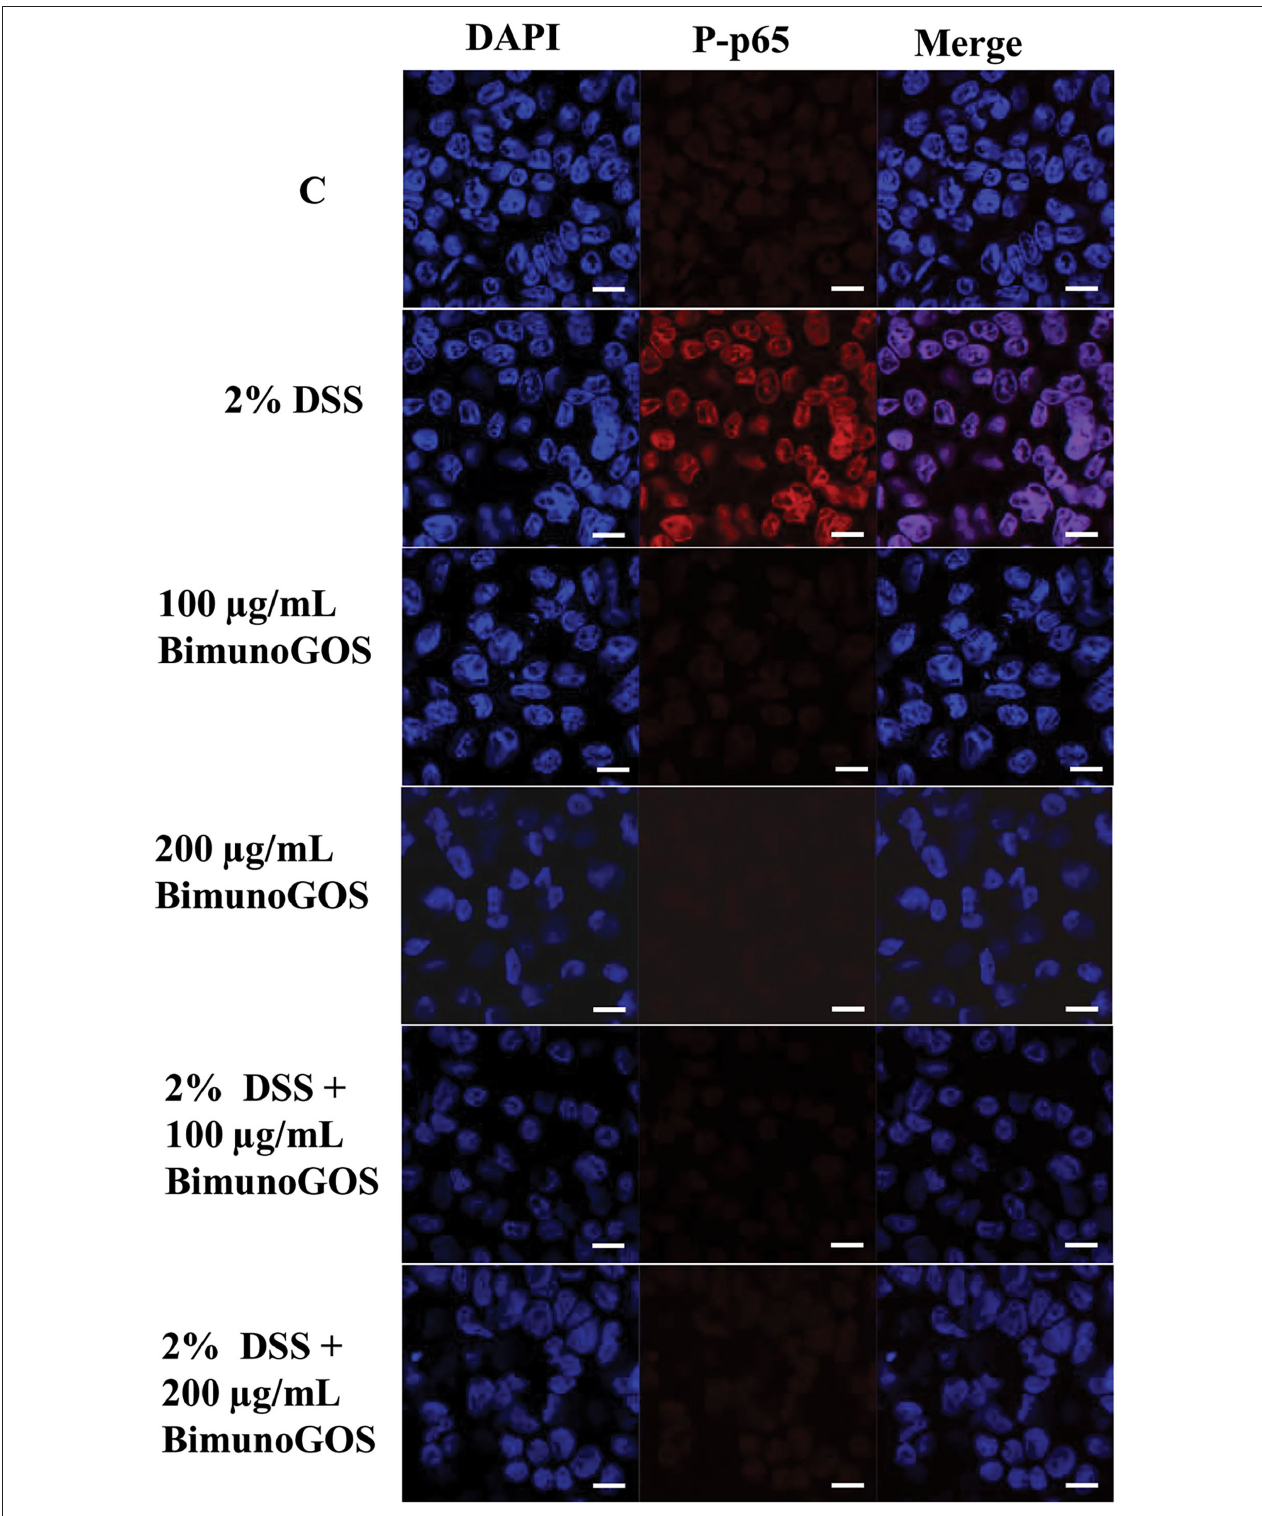
FIGURE 7 | Inhibition of DSS induced-P-p65 translocation by Bimuno GOS in Caco-2 cells. Cells were untreated (C), or treated with 2% DSS for 6h, or treated with Bimuno GOS (100 or 200 µ g/ml) for 4h, or treated with 2% DSS for 2h and then with Bimuno GOS (100 or 200 µ g/ml) for further 4h. Cell nuclei were stained with DAPI, while P-p65 was labeled with rabbit polyclonal anti-P-p65 antibody, followed by TRITC-conjugated secondary antibody. Each figure is representative of three independent assays (63 × magnification). Bars represent 10 µ m.